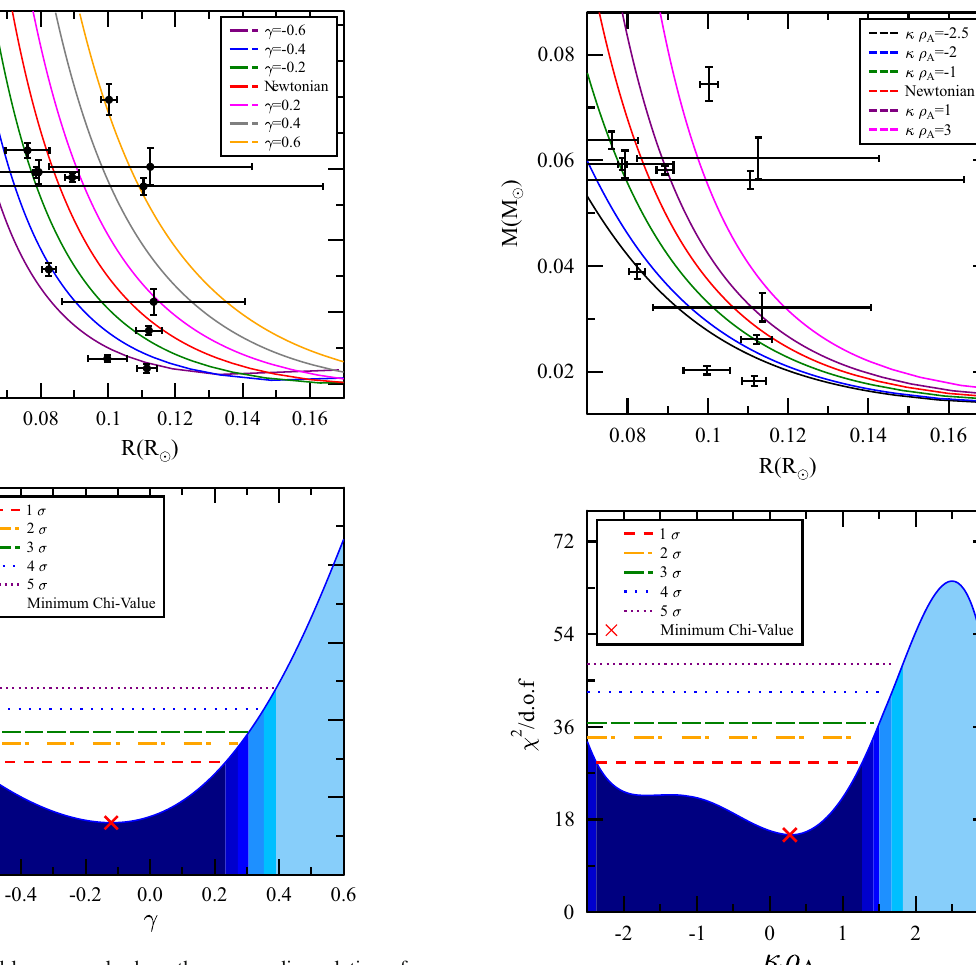
Fig. 1 The upper and lower panels show the mass-radius relation of the BD calculations for the current epoch based on BH theory with a variety of γ values and the corresponding chi-square per d.o.f vs γ relation. The corresponding observation data of [1] with the associated error bars are also given. Here, d . o . f = 22. The shaded area with the